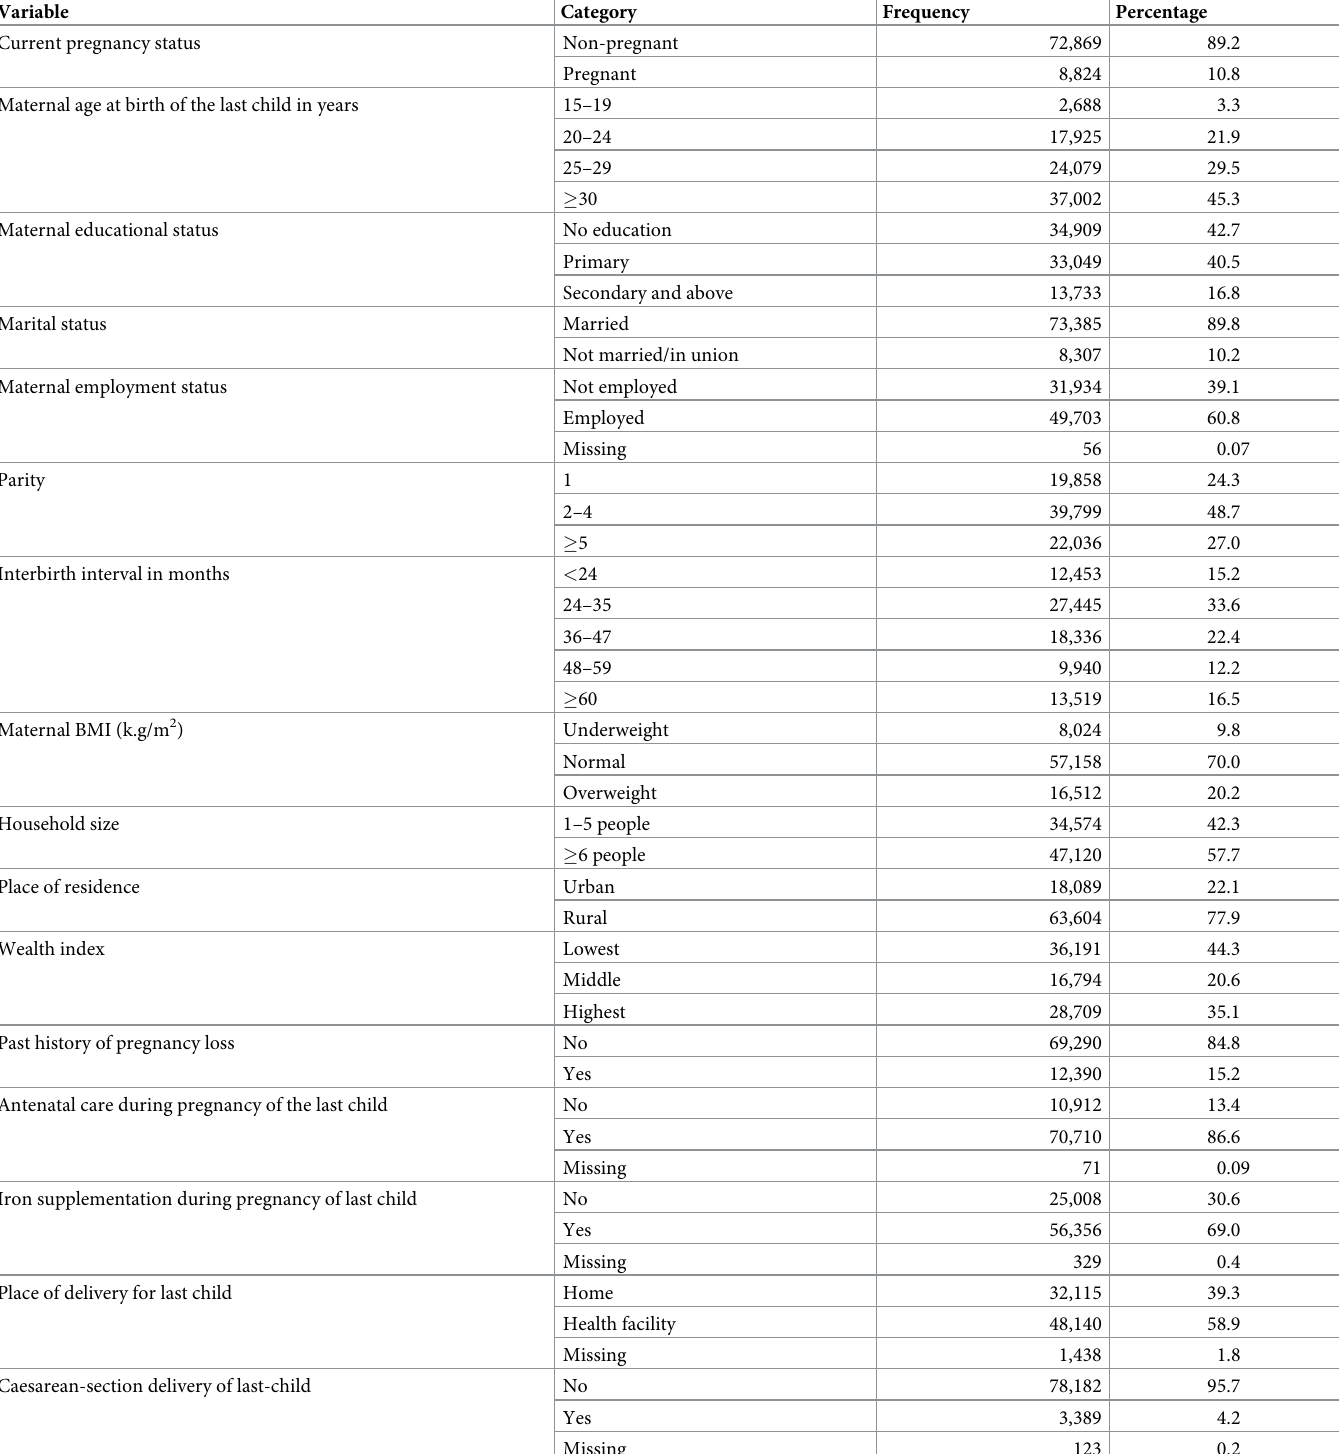
Table 1. Sociodemographic, household and health services characteristics of the participant women in the analysis population (n = 81,693) in sub-Saharan Africa